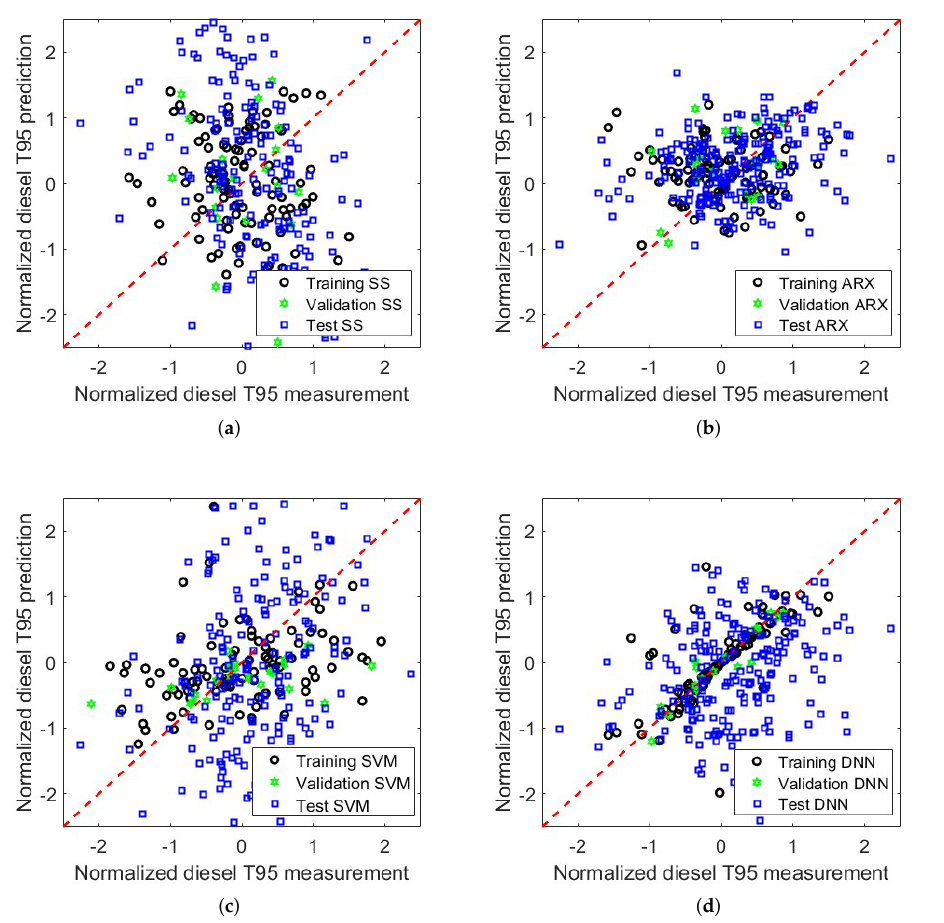
Figure 5. Data-driven model training and validation points against measurements. ( a ) State space model predictions compared against the measurements. ( b ) ARX model predictions compared against the measurements. ( c ) SVM regression model predictions compared against the measurements. ( d ) DNN model predictions compared against the